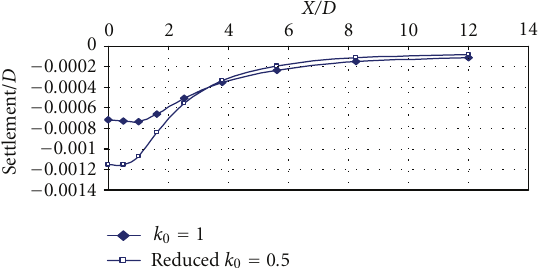
Figure 23: The surface horizontal displacement using reduced k 0 values.